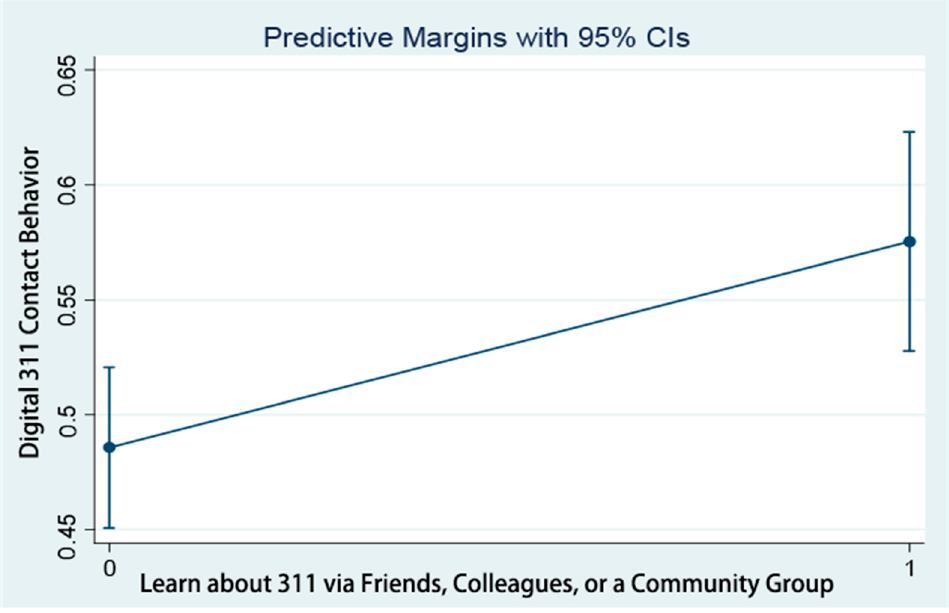
Figure 3. Estimated probabilities of digital 311 contact behavior caused by learning about 311 via friends, colleagues, and community groups.